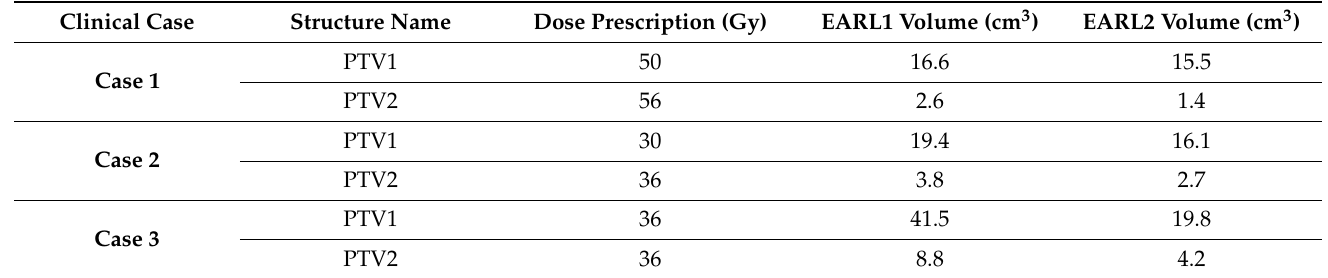
Table 6. Segmented structures for each clinical case evaluated, prescription dose, and volume values in reconstructed images according to EARL1 and EARL2 accreditations.